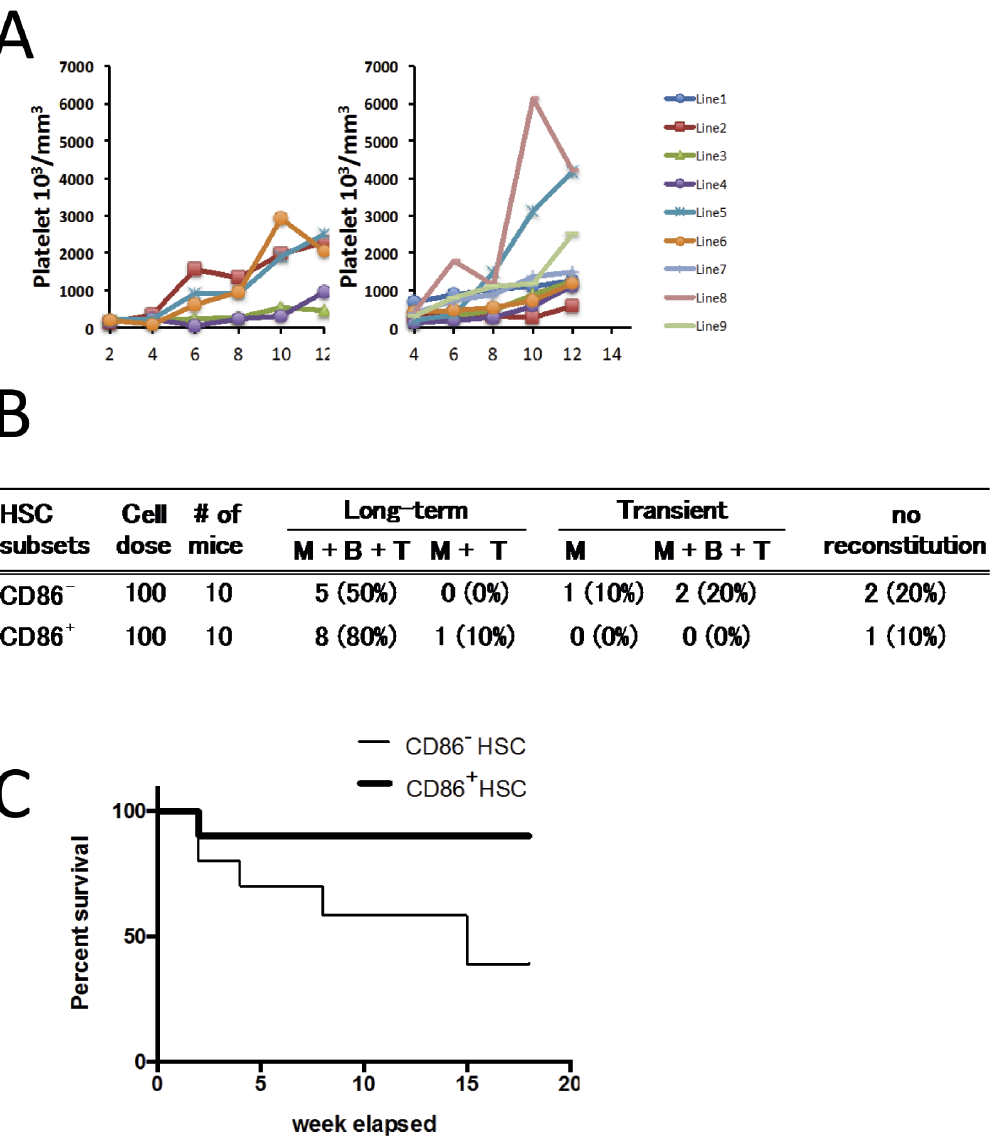
Figure 7. The JAK2V617F transgene initiates disease in both CD86 + and CD86 2 HSC subsets. One hundred CD86 + or CD86 2 CD150 + CD48 2 HSC from CD45.2 JAK2V617F transgenic mice were transplanted to lethally irradiated CD45.1 recipient mice. ( A ) This table summarizes recipients that survived for at least 18 weeks after transplantation. Effective chimerism was considered if the recipients had more than 1.0% donor cells in the peripheral blood. ( B ) Platelet counts are shown at the indicated intervals. ( C ) Survival curves are given for recipients of the two HSC subsets.